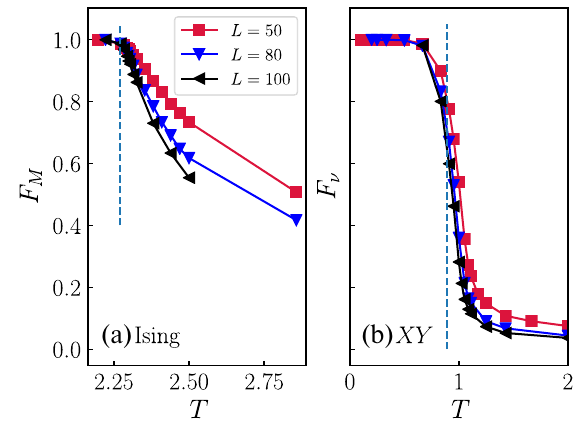
FIG. 8. Connectivity between neighboring points. Panel (a) shows the fraction of points in the Ising data set whose first two nearest neighbors have the same magnetization sign. Sim- ilarly, in panel (b), we show the fraction of points in the XY data set whose first two nearest neighbors have the same winding number (see text).